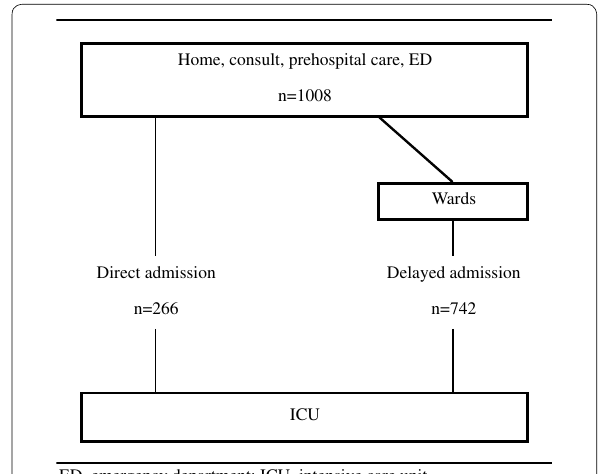
Fig. 1 Flowchart of patients depending on their modalities of admission to